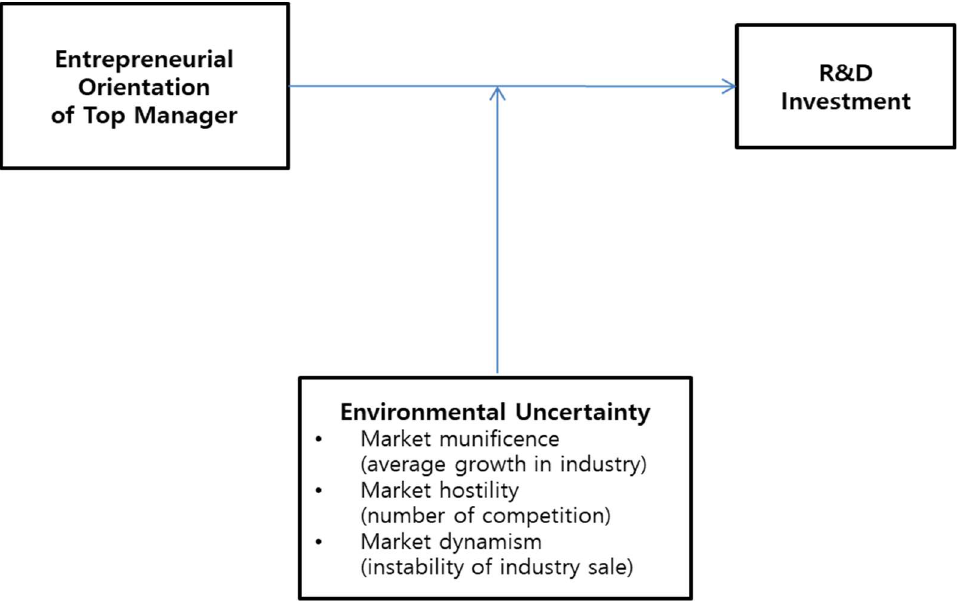
Figure 1. The research model.